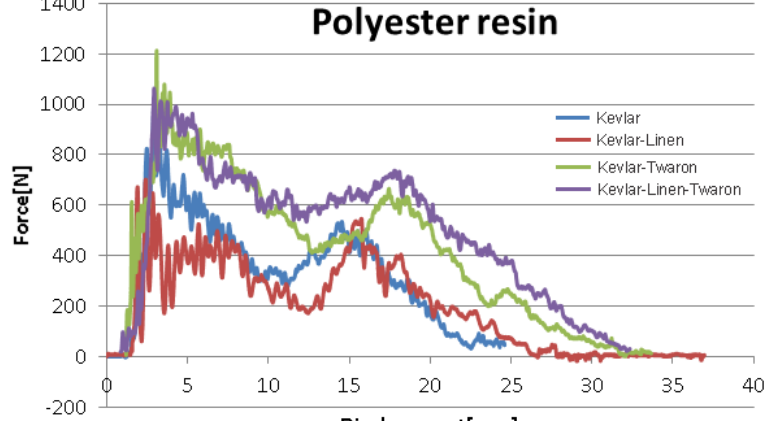
Figure 10. Force displacement curves—EPOXY resin .